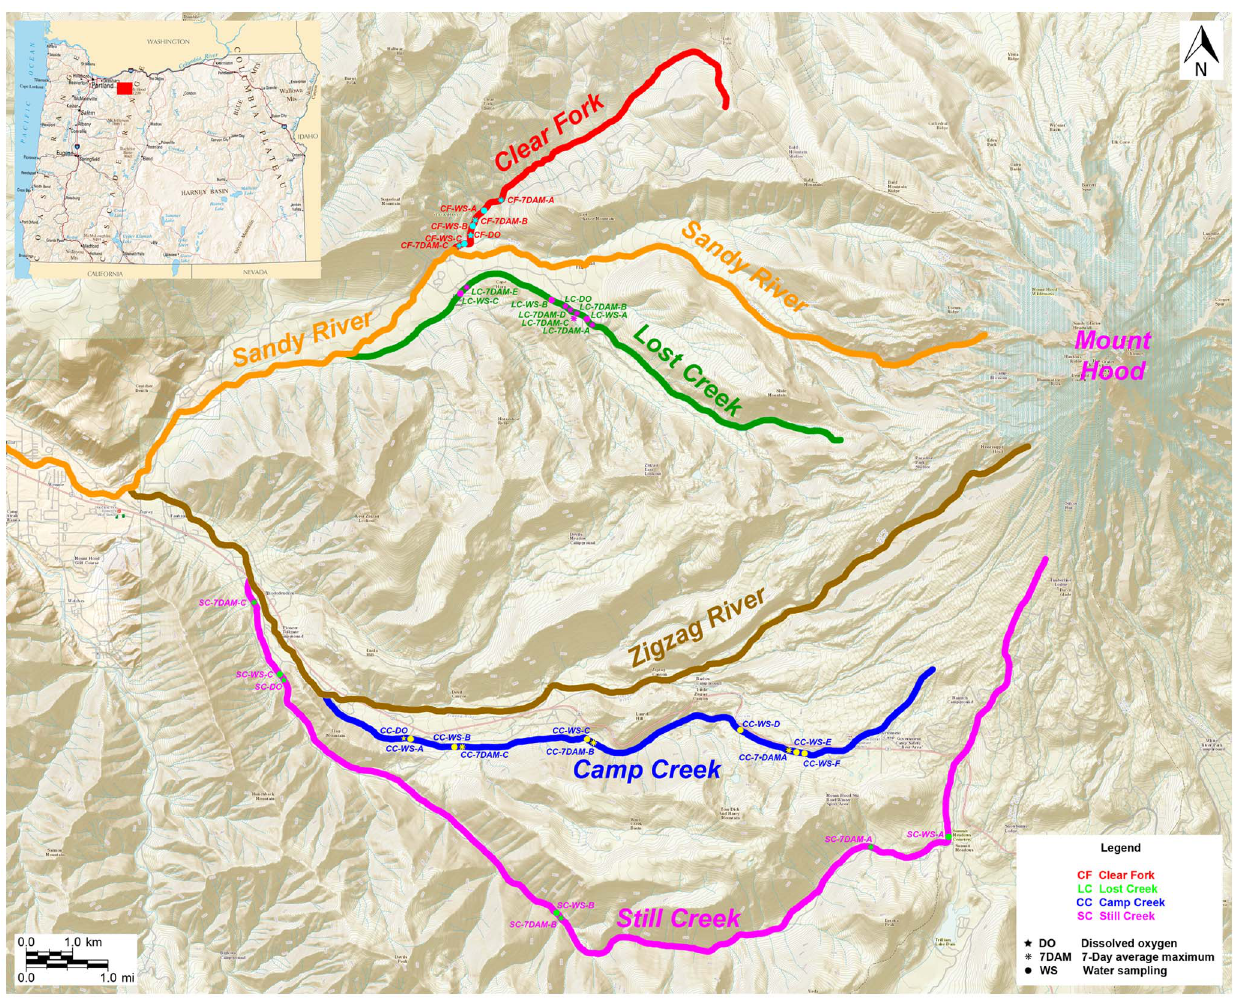
Figure 1. Map showing the location of the sampling sites in Oregon (insert) and along the four streams on Mount Hood. Stars indicate the location of dissolved oxygen sampling sites, asterixes indicate the location of temperature sampling sites, and circles indicate the sites for bacterial water sampling. Clear Fork and Lost Creek flow directly into the Sandy River, and Camp Creek and Still Creek flow into the Zigzag River, which is a tributary of the Sandy